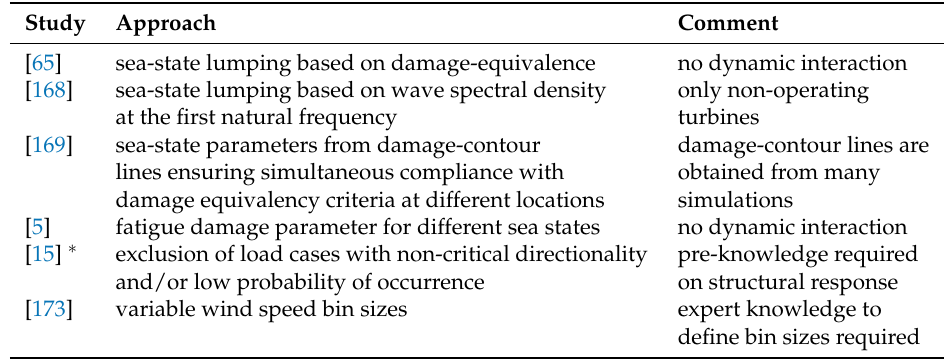
Table 4. Overview of studies presenting approaches to reduce the number of environmental load cases.